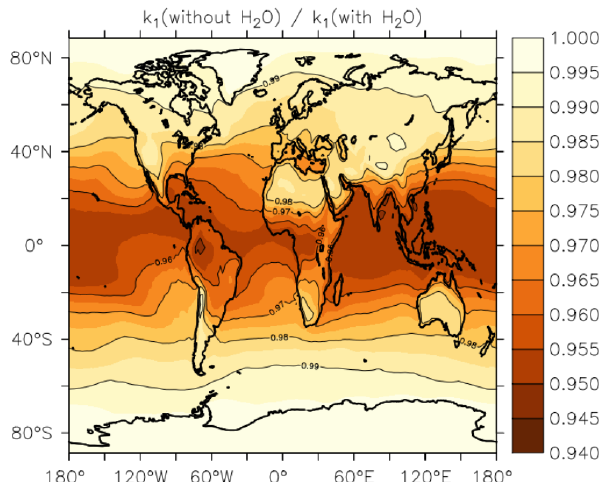
Figure 13. Annual, average effect of H 2 O on k 1 expressed as the fractional change in the rate coefficient near the Earth’s surface (al- titude of 1–2km) when setting the mole fraction of water vapour to zero in Eqs. (5) and